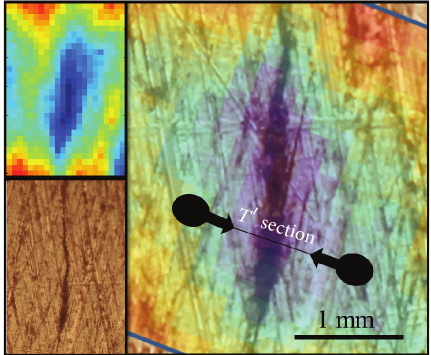
Figure 9: Cooling rate matrix of the new crack, with pseudocolor assigned to each cooling rate value (top left) and macrophotography of the crack (bottom left). Overlapping of cooling rate map with macrophotography of the crack in order to correlate the different depths of the crack with the different cooling rate data (right). The transversal section 𝑇 󸀠 used to assess the prediction model has been